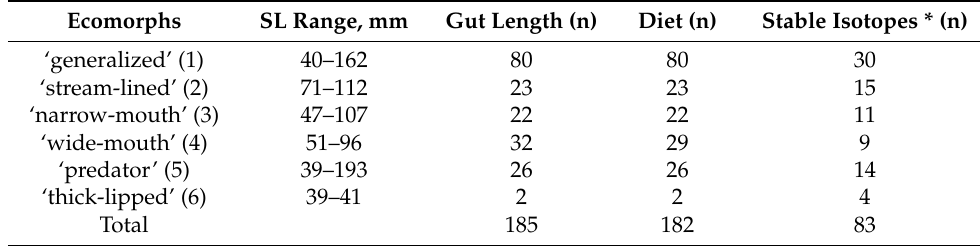
Table 1. Sample size of the studied ecomorphs of Garra in the Sore River. Ecomorphs SL Range, mm Gut Length (n) Diet (n) Stable Isotopes * (n) ‘generalized’ (1) 40–162 80 ‘stream-lined’ (2) 71–112 ‘narrow-mouth’ (3) 47–107 ‘wide-mouth’ (4) ‘predator’ (5) 39–193 ‘thick-lipped’ (6) 39–41 Total